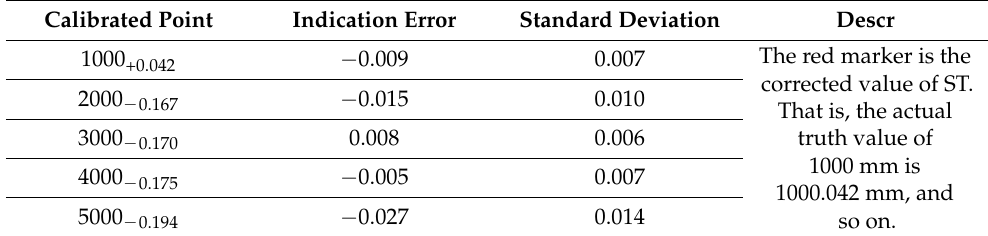
Table 1. Repeatability test results (unit: mm).